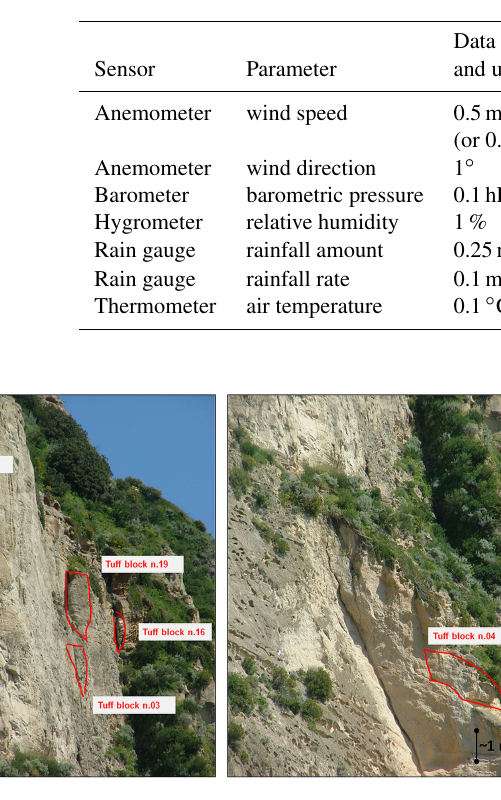
Figure 5. Unstable tuff blocks of the NYT unit selected for moni- toring activity (red